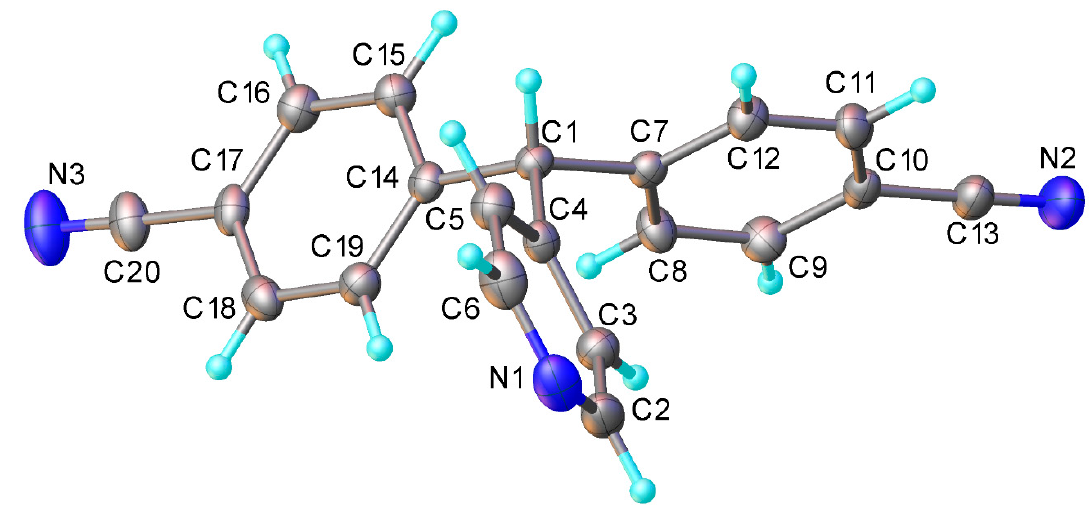
Figure 4. The X-ray structure recorded for compound 3 .